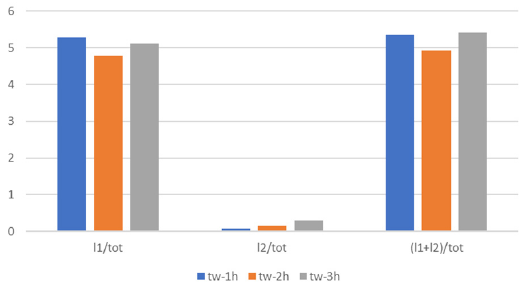
Figure 7. Time window durations and % of postponed deliveries.